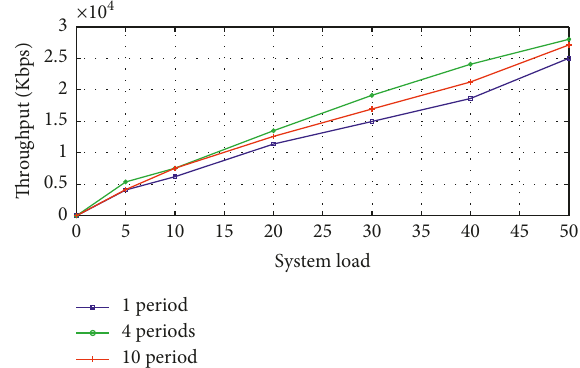
Figure 5: Call blocking probability (shower rain).